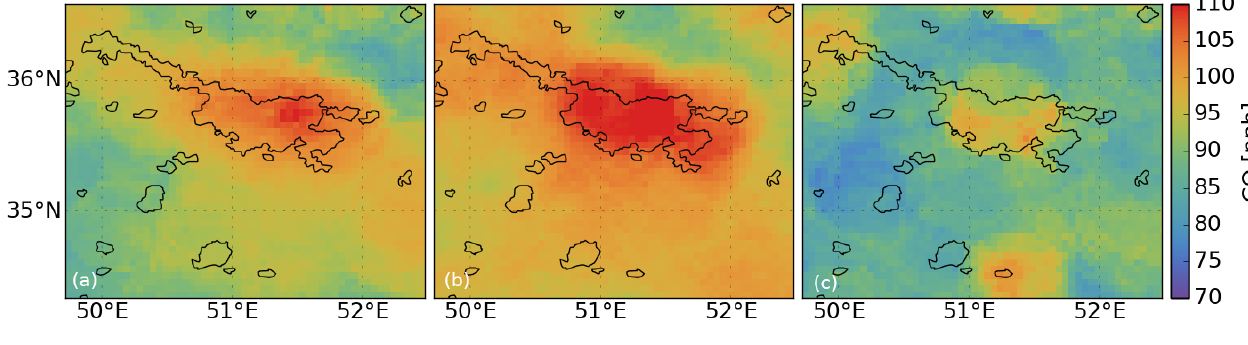
Figure 8. Same as Fig. 7 but for Tehran.